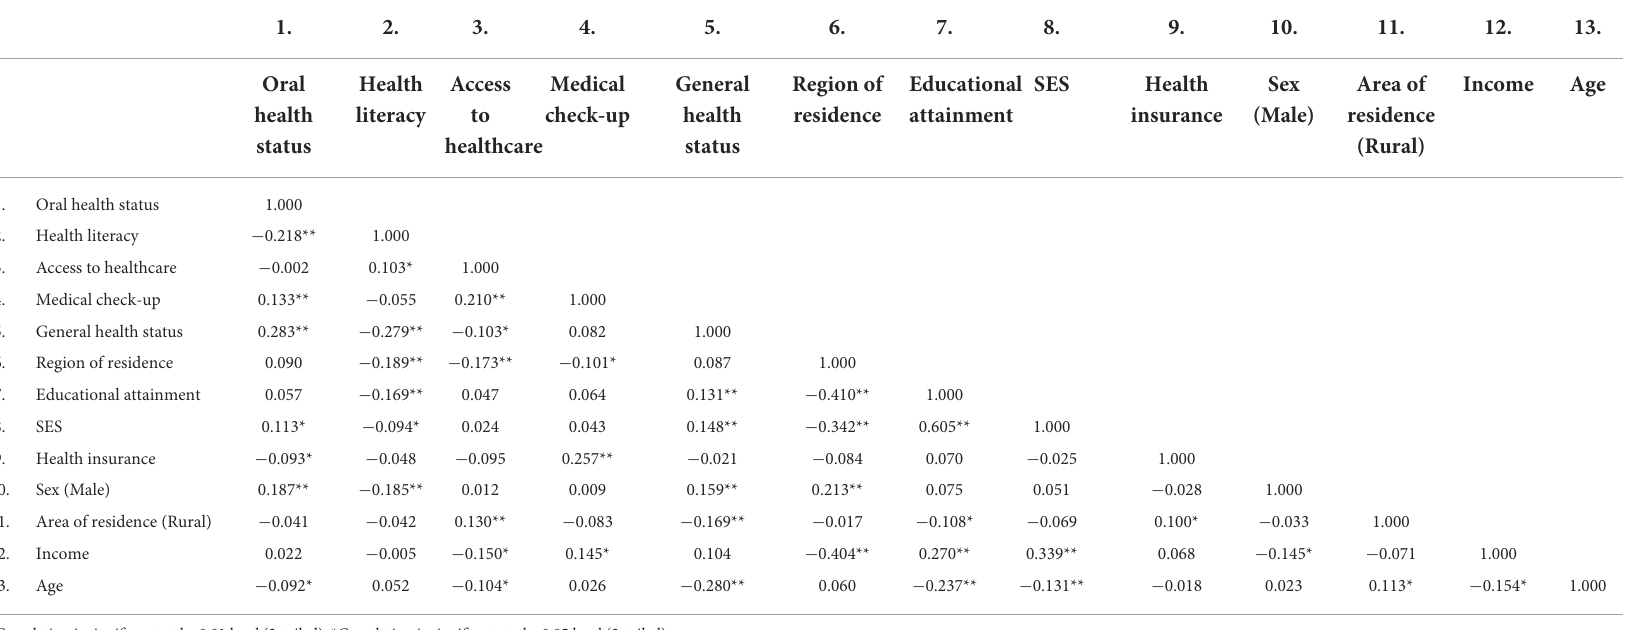
TABLE 2 Spearman’s correlation analyses of variables in the